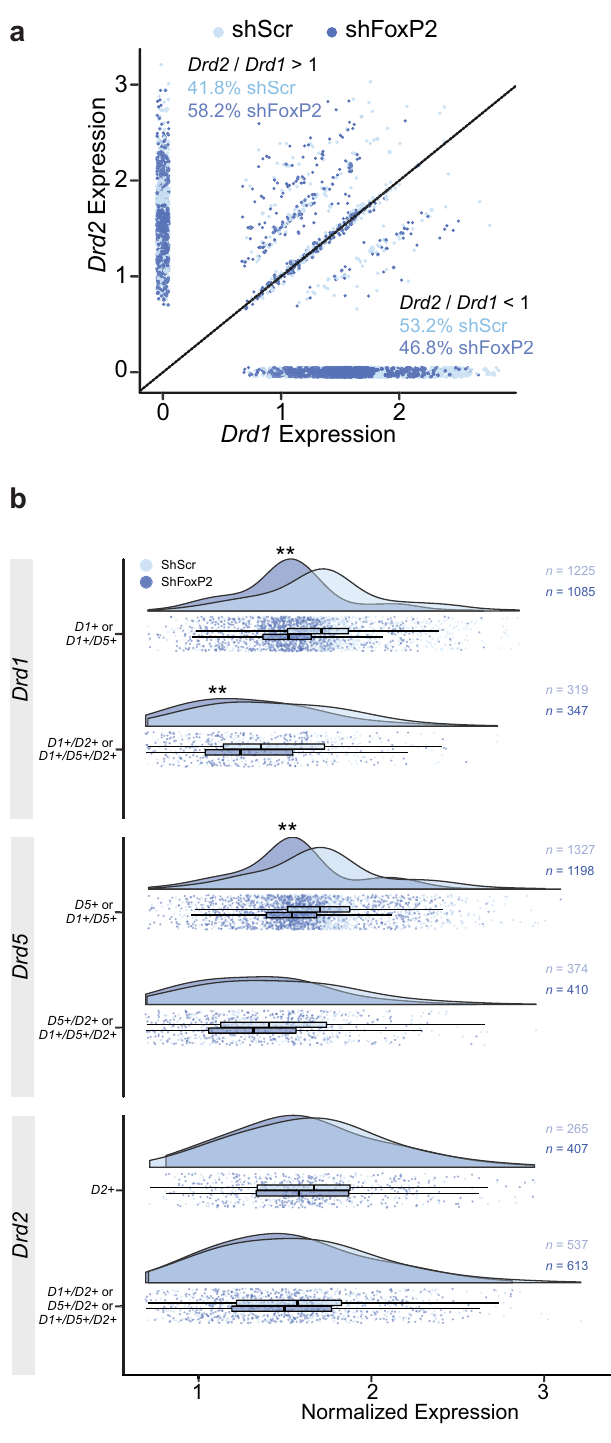
Fig. 6 Altered expression of dopamine receptors resulting from FoxP2 knockdown. a A scatterplot illustrating the correlation between normalized expression of Drd1 and Drd2 in FoxP2 + striatal cells that are also Drd1 + or Drd2 + . Each point represents a nucleus. Diagonal line indicates the line of equality. Cells above the line have a ratio of Drd2 / Drd1 greater than 1. Cells below the line have a ratio of Drd2 / Drd1 below 1. b Distribution and boxplots of normalized expression for Drd1 , Drd5 , and Drd2 in FoxP2 + MSNs in CS-shScr + and CS-shFoxP2 + birds. Cells are grouped by the expression